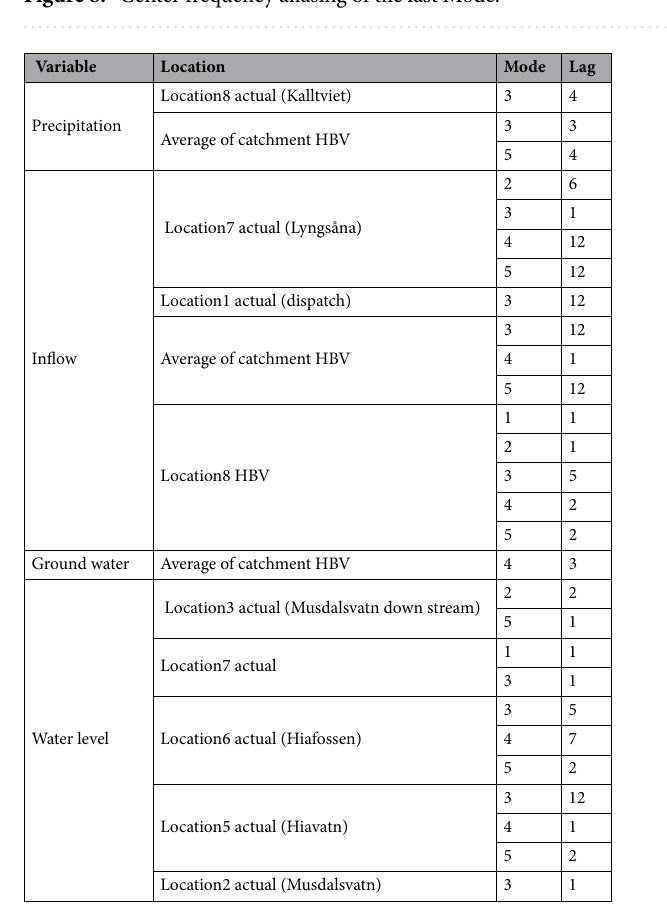
Figure 8. Center frequency aliasing of the last Mode.